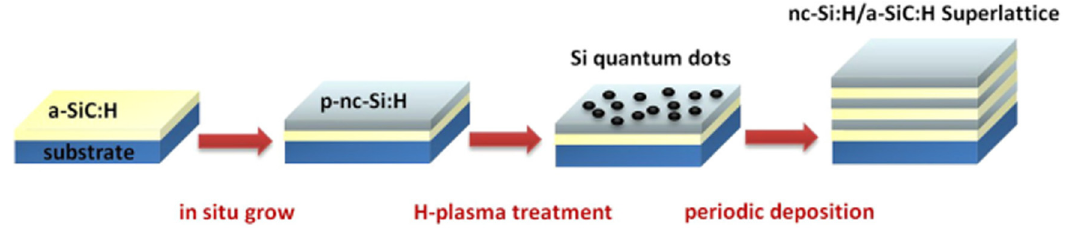
Figure 12: The detailed deposition process of boron doped nc - Si:H/a - SiC:HQDSL samples [ 52 ] .